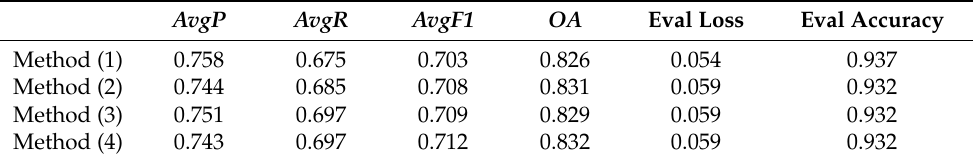
Table 5. The result of different layer sizes number on point-level and global-level.